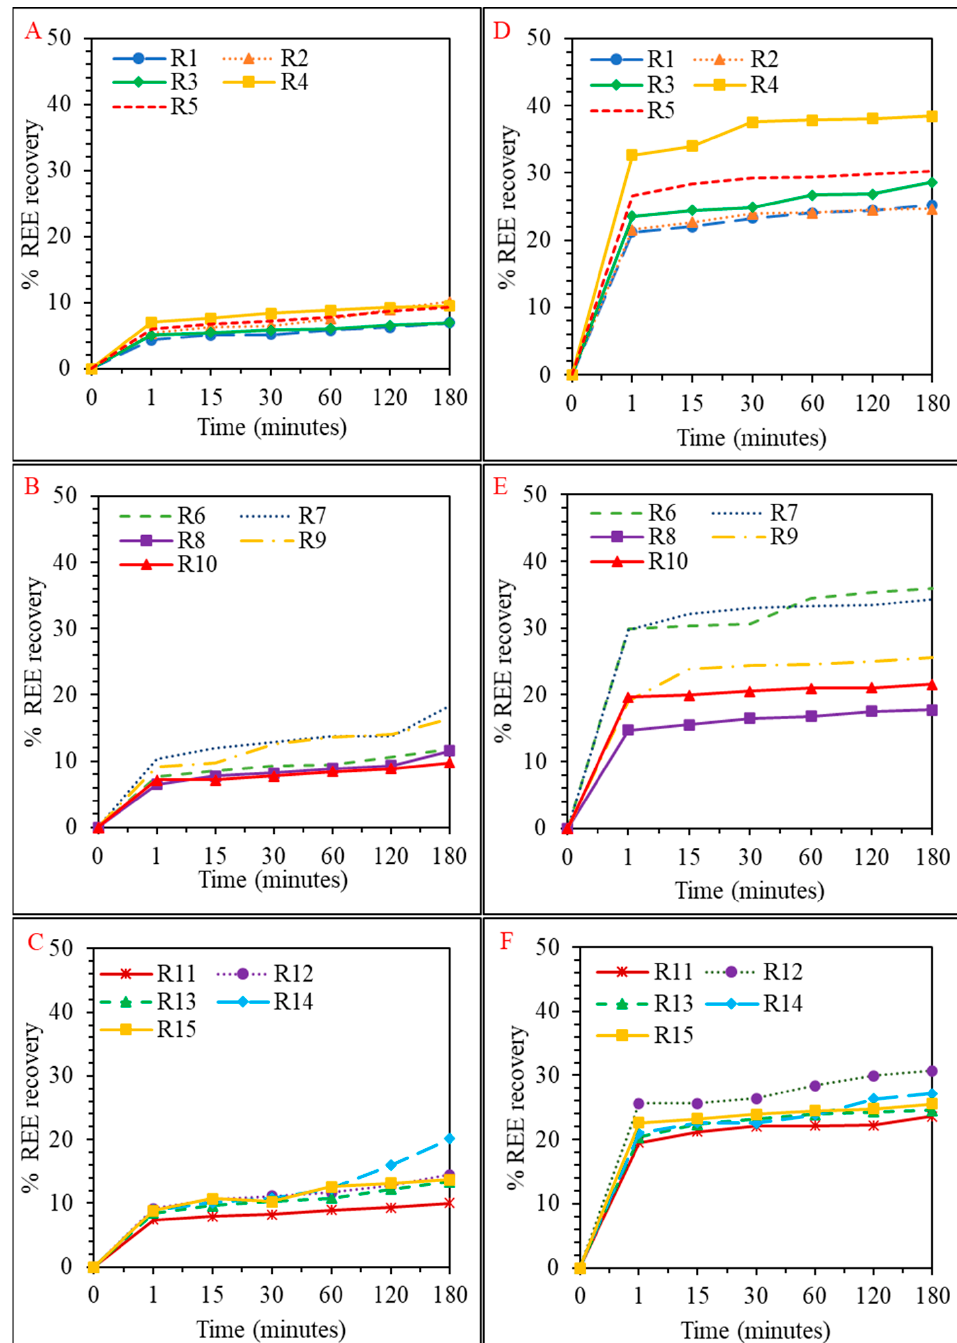
Figure 1. The % REE recovery of RC1 ( A – C ) and DC1 ( D – F ) after leaching according to the DOE test matrix.